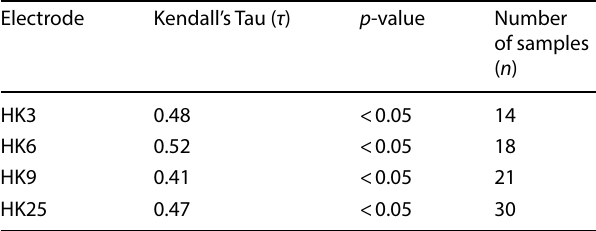
Table 4 Results of the correlation tests of the residual hydrogen content H and the water depth d R